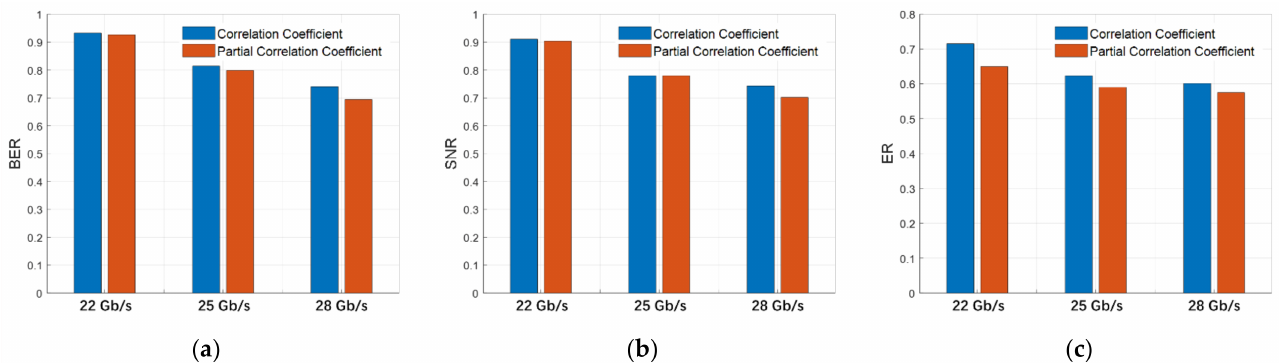
Figure 6. Absolute value of the correlation coefficients and partial correlation coefficients of average S 11 with performance parameters: ( a ) BER, ( b ) SNR, and ( c )